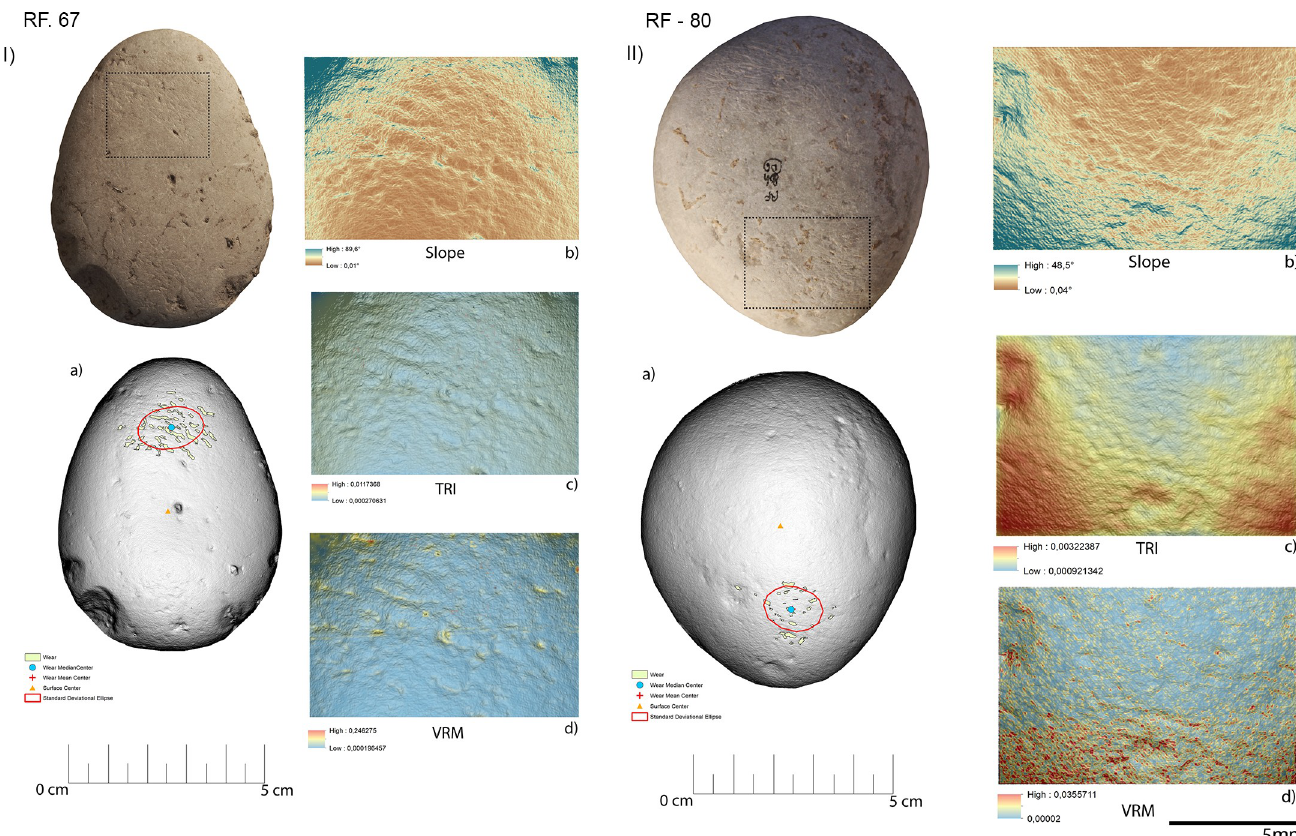
Fig 26. Archaeological items, RF67 (I) and RF80 (II), utilized in scaled retouching and marginal retouching. (a) Spatial distribution of the identified wear; (b) slope; (c) terrain roughness index; (d) vector roughness